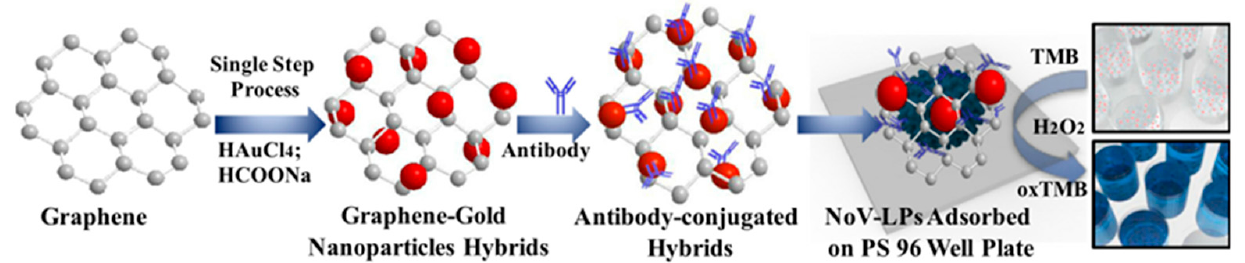
Figure 4. Antibody-modified graphene/AuNP hybrids for detection of norovirus (NOV-LP). Reprinted with permission from Ref. [64], Copyright 2017, Elsevier.